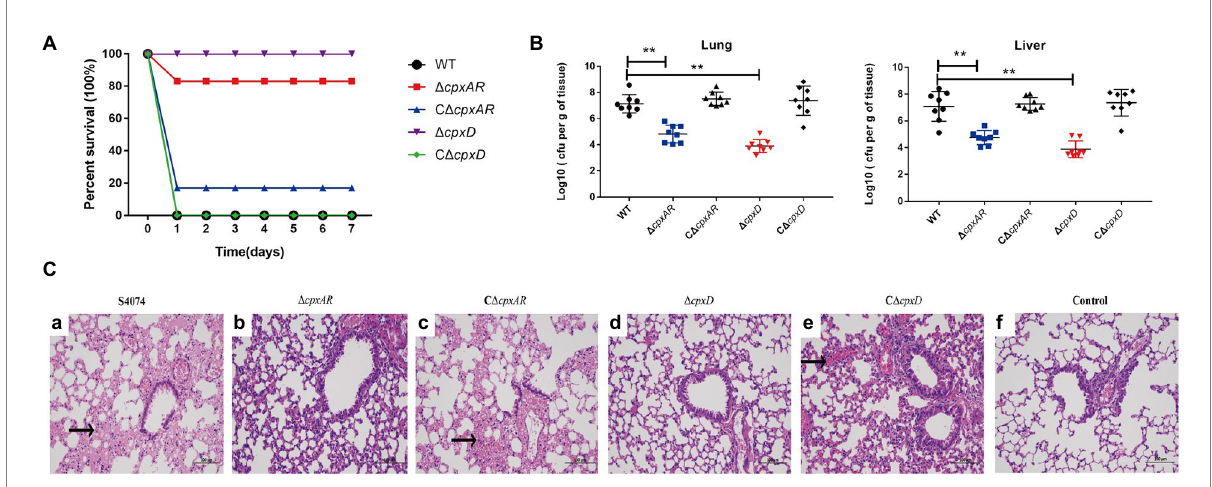
FIGURE 4 CpxAR and CpxD contribute to the virulence and colonization of A. pleuropneumoniae . The survival rates (A) , bacterial loads in the lungs and livers (B) , and histopathology of the lung tissues (C) of Kunming mice challenged with the WT S4074 (a), Δ cpxAR (b), Δ cpxD (c), C Δ cpxAR (d), and C Δ cpxD (e) strains at a dose of 1 × 10 7 CFU/mouse. The control group (f) was only injected with 100 µl of PBS ** p <